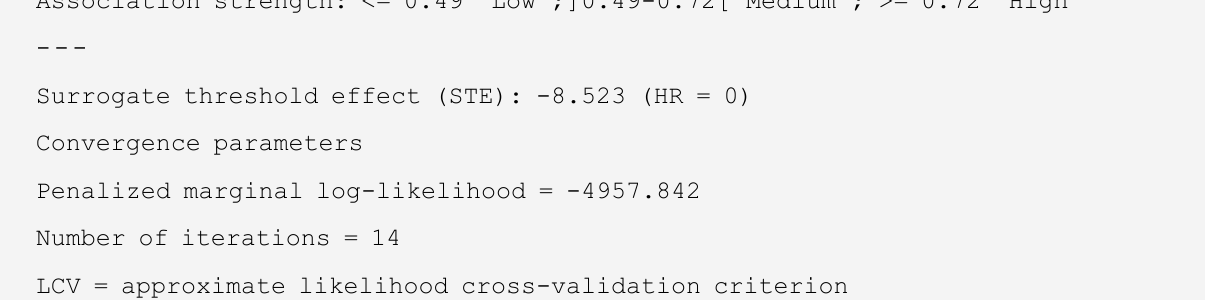
LCV = approximate likelihood cross-validation criterion in the semi-parametrical case =